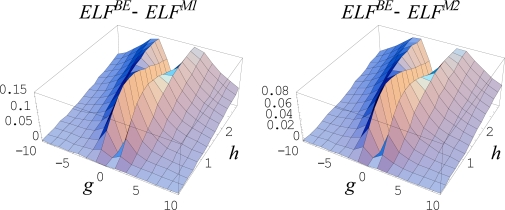
The differences in electron localization functions (ELFs) between the Becke-Edgecombe (BE) and Markovian (M1) and (M2) formulations of Equations (469), (495), and (496), in left and right, respectively, versus the homogeneous (h-parameter) and inhomogeneous (g-parameter) influences on electronic distribution.